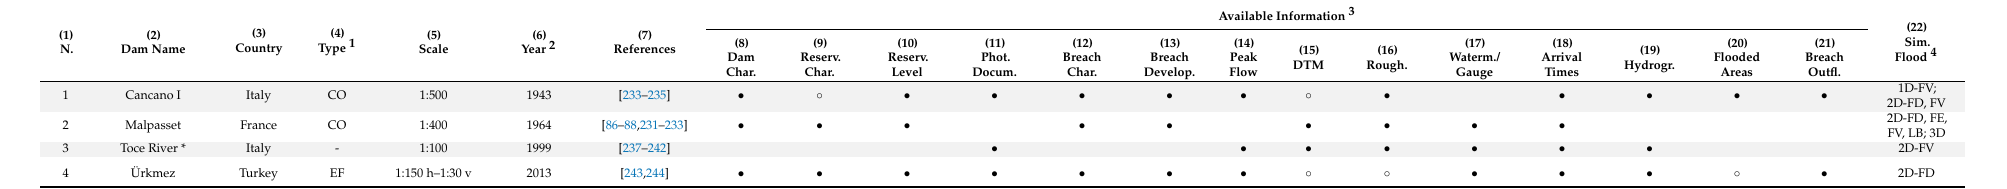
Table 3. Physical models of dam-break on real